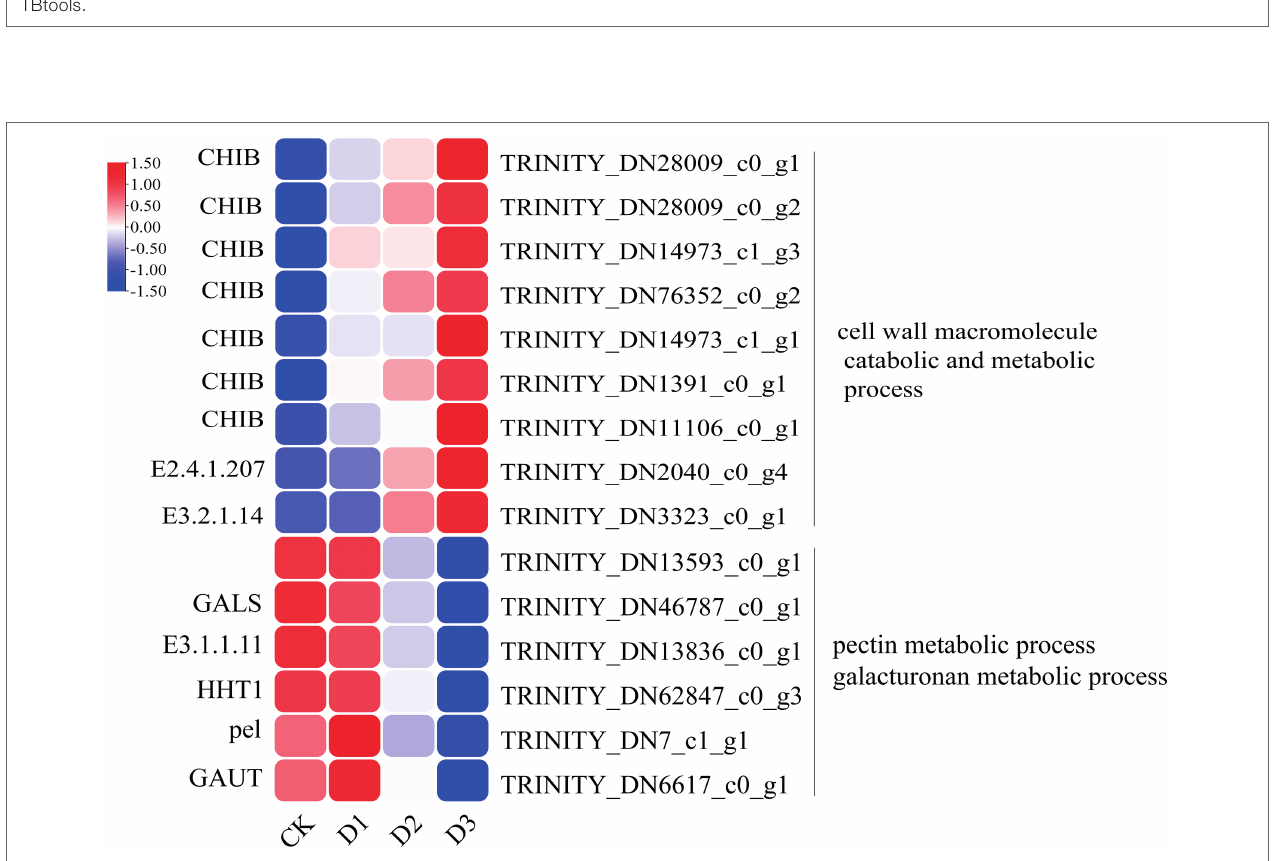
FIGURE 3 | The significant differentially expressed unigenes related to cell wall and pectin was significant enriched of GO items in the CK verse D3. The color was showed the expression values (log 10 (TPM)), and the red represent high TPM. The figures were visualized by